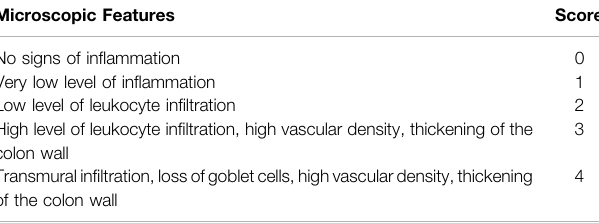
TABLE 4 | Histological scoring system (microscopic evaluation of in fl